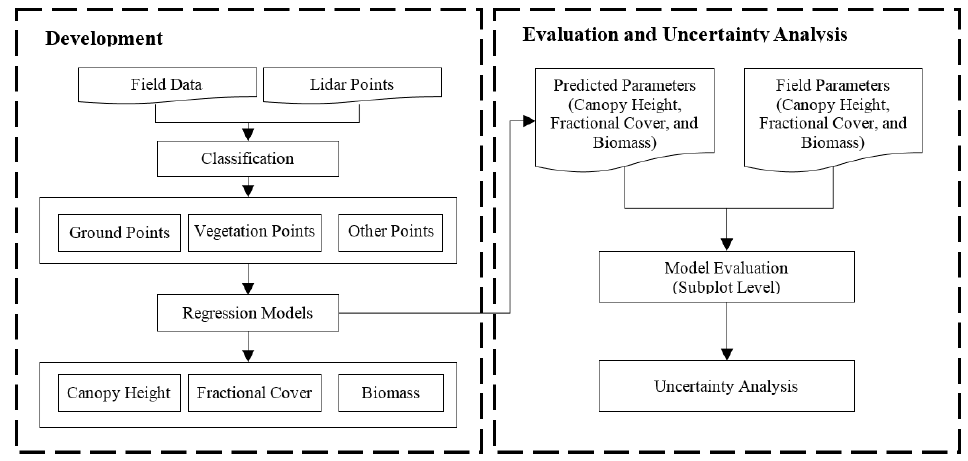
Figure 1. Workflow for model development, evaluation, and uncertainty analysis for mapping canopy height, fractional cover, and biomass maps based on lidar data.